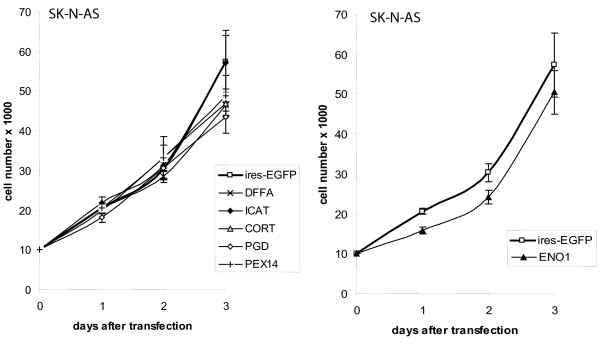
Cell growth curves of cDNA-transfected cells monitored for 3 days after transfection. The average number of cells in 8 separate experiments is shown at each time point for each construct. Standard deviation is indicated with a bar. A: Cell growth after transfection of five different constructs compared to empty vector (pIRES-EGFP) control in SK-N-AS cells. Using Students T-test, no significant differences in cell number compared to control cells could be detected for the first two days after transfection for any of the constructs, three days after transfection DFFA (p = 0.002), CORT (p = 0.004) and PGD (p < 0.001) showed significant difference. B: Cell growth after transfection of ENO1 compared to empty vector control. Significant differences in cell number was detected day 1 (p < 10-8) and day 2 (p < 10-4), the difference was not significant day 3 after transfection.